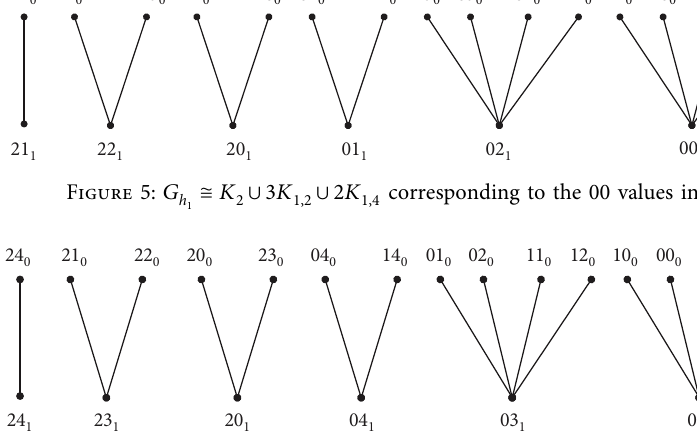
� K ∪ 3 K ∪ 2 K corresponding to the 00 values in C h 2 2 1 , 2 1 , 4